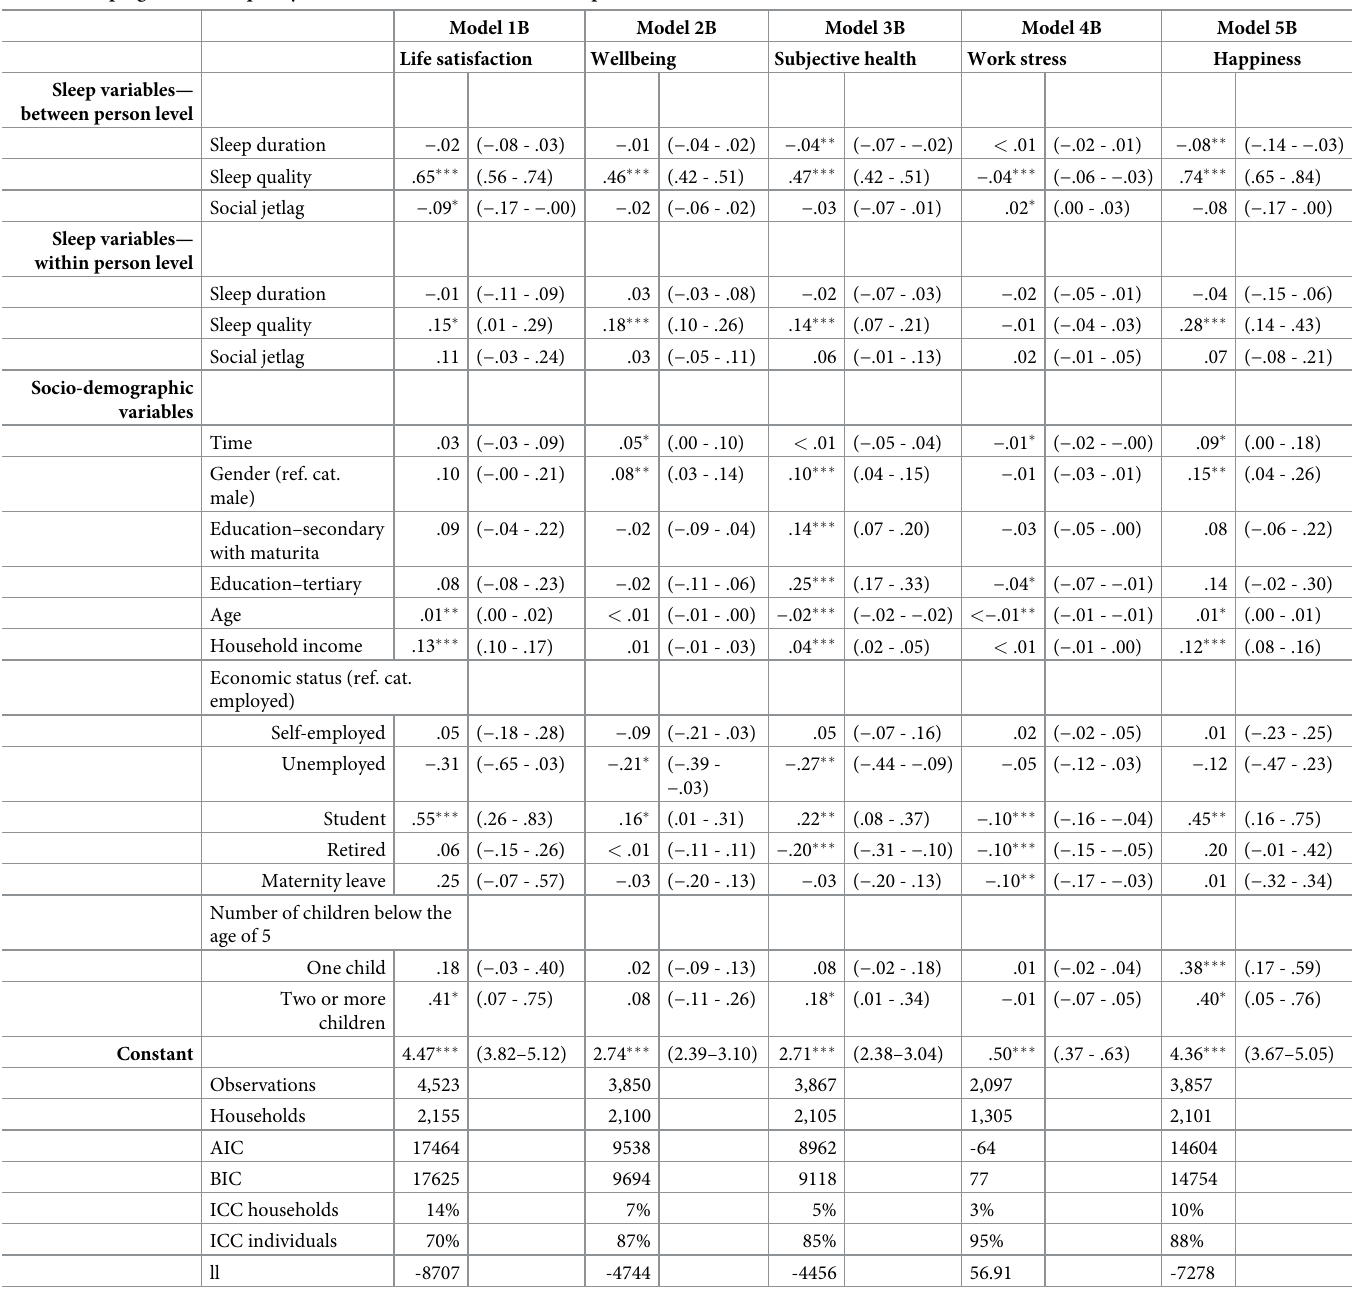
Table 3. Sleeping habits and quality of life, linear mixed models with repeated